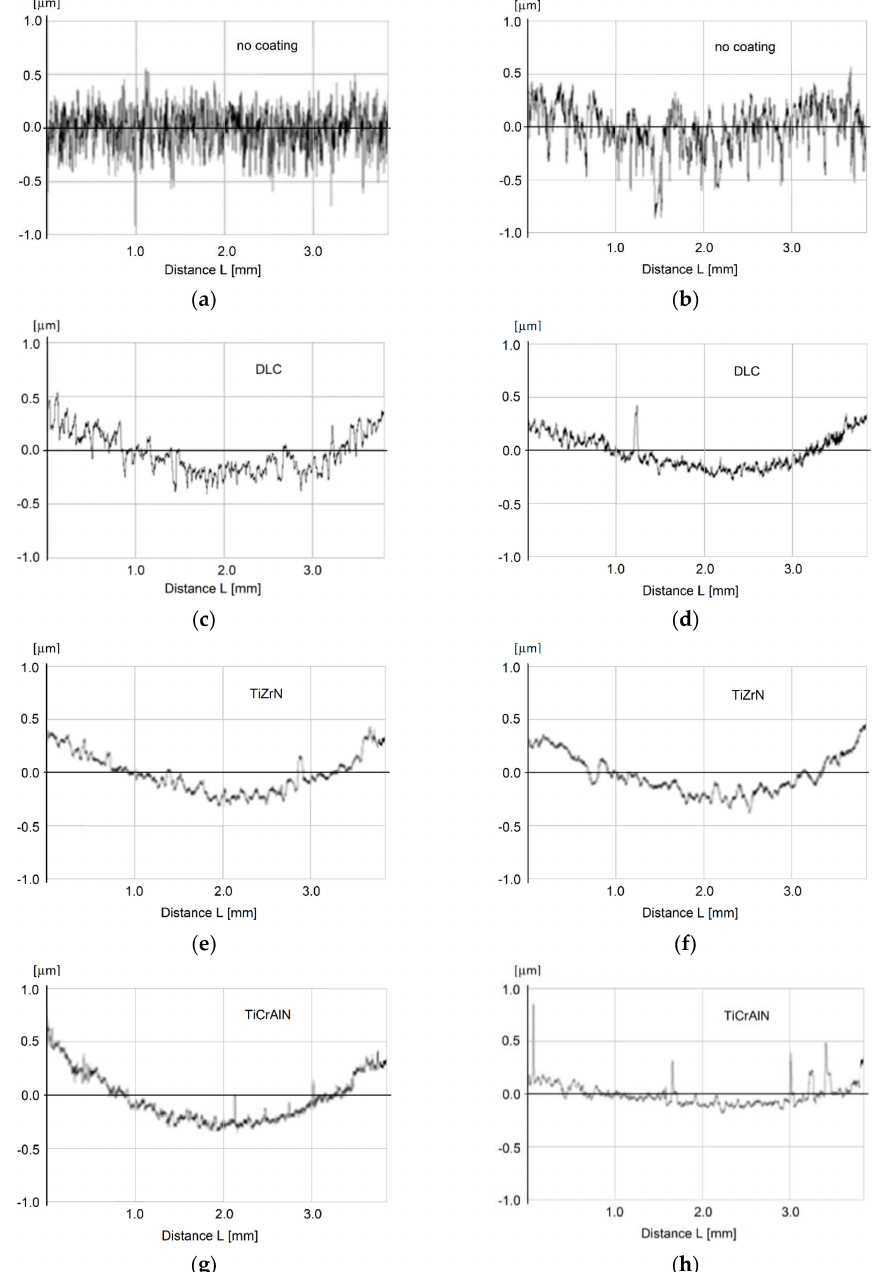
Figure 6. Profilograms from the front surface of the ceramic samples before coating and after depositing coatings: ( a ) The Al 2 O 3 + TiC ceramic sample before coating; ( b ) The Al 2 O 3 + SiC ceramic sample before coating; ( c ) The Al 2 O 3 + TiC ceramic sample after depositing the diamond-like coating; ( d ) The Al 2 O 3 + SiC ceramic sample after depositing the diamond-like coating; ( e ) The Al 2 O 3 + TiC ceramic sample after depositing the TiZrN coating; ( f ) The Al 2 O 3 + SiC ceramic sample after depositing the TiZrN coating; ( g ) The Al 2 O 3 + TiC ceramic sample after depositing the TiCrAlN coating; ( h ) The Al 2 O 3 + SiC ceramic sample after depositing the TiCrAlN